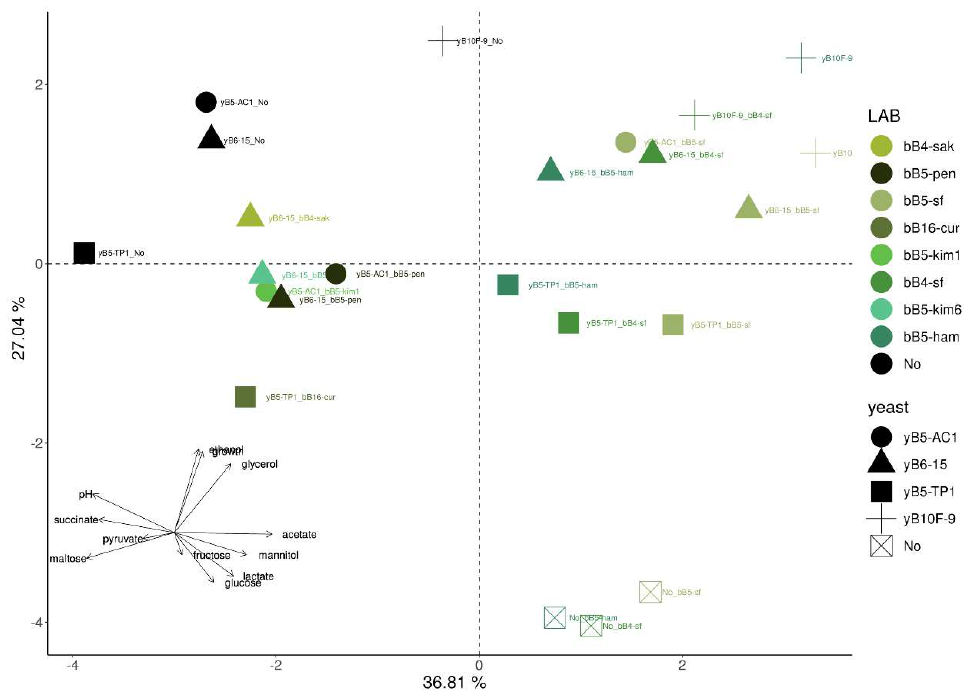
Figure 6. Principal component analysis based on average metabolite levels, pH, and dough height of fermentation. LAB strains are represented with different colors and yeast strains with different symbols. Arrows represent a graphical representation of the loadings of each original variable.